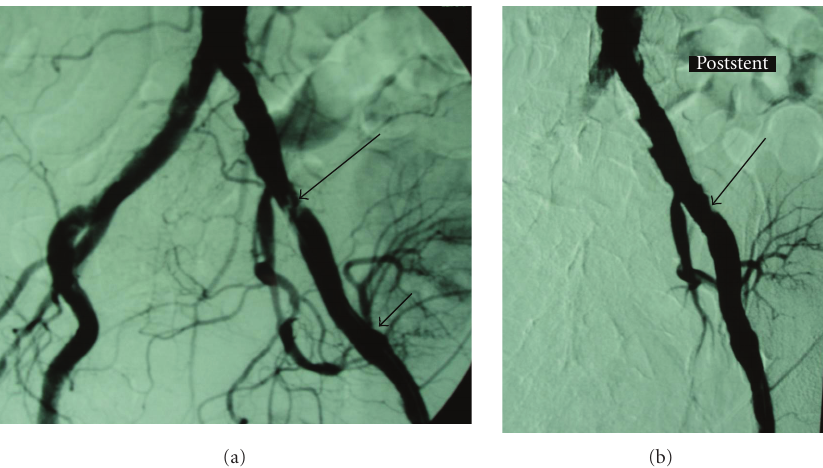
Figure 3: (a) Atheromatous lesions in the iliac arteries, especially at the proximal part of the left external iliac artery (big arrow). Note the anastomosis of the transplant renal artery to the left external iliac artery, a few centimeters distal to this lesion (small arrow). This severe stenosis of the left external iliac artery was responsible for claudication as well as graft’s dysfunction. (b) Image post-angioplasty and stent deployment in the left iliac artery (arrow).